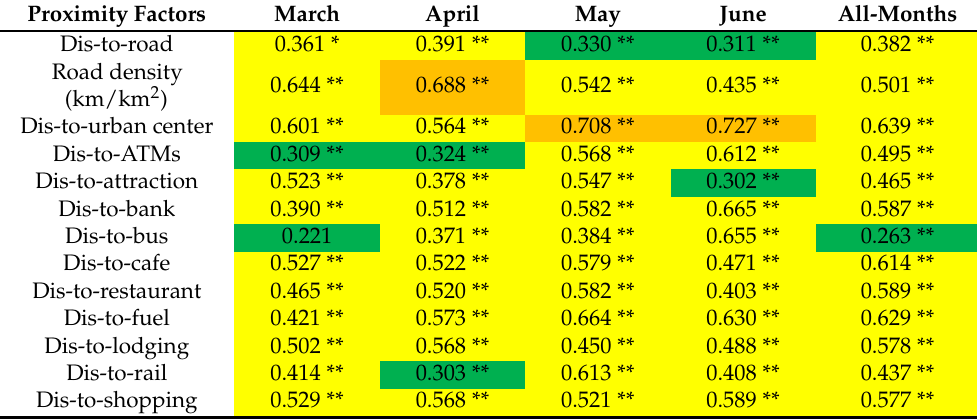
Table 1. Correlation ratio (Eta) between proximity factors and hotspot patterns.